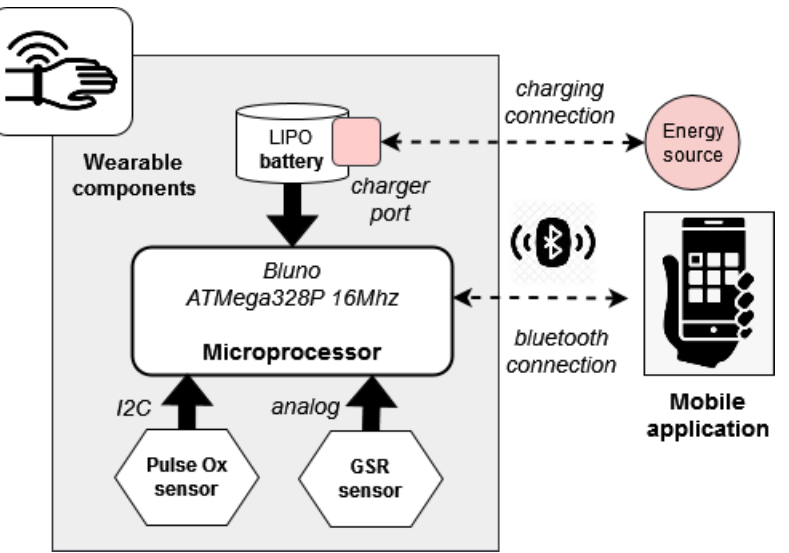
Figure 2. Hardware components integrated into the